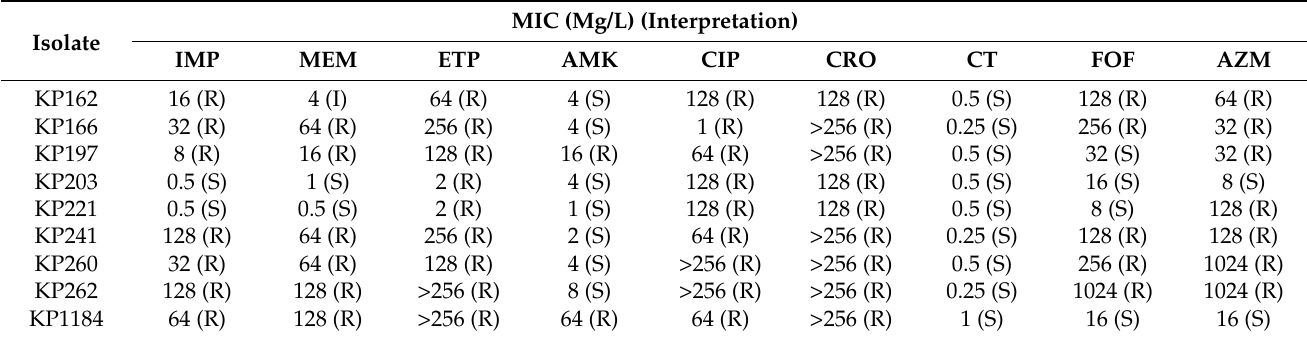
Table 1. Antibiotic susceptibility of nine OXA-48-producing K. pneumoniae isolates. MIC (Mg/L) Isolate